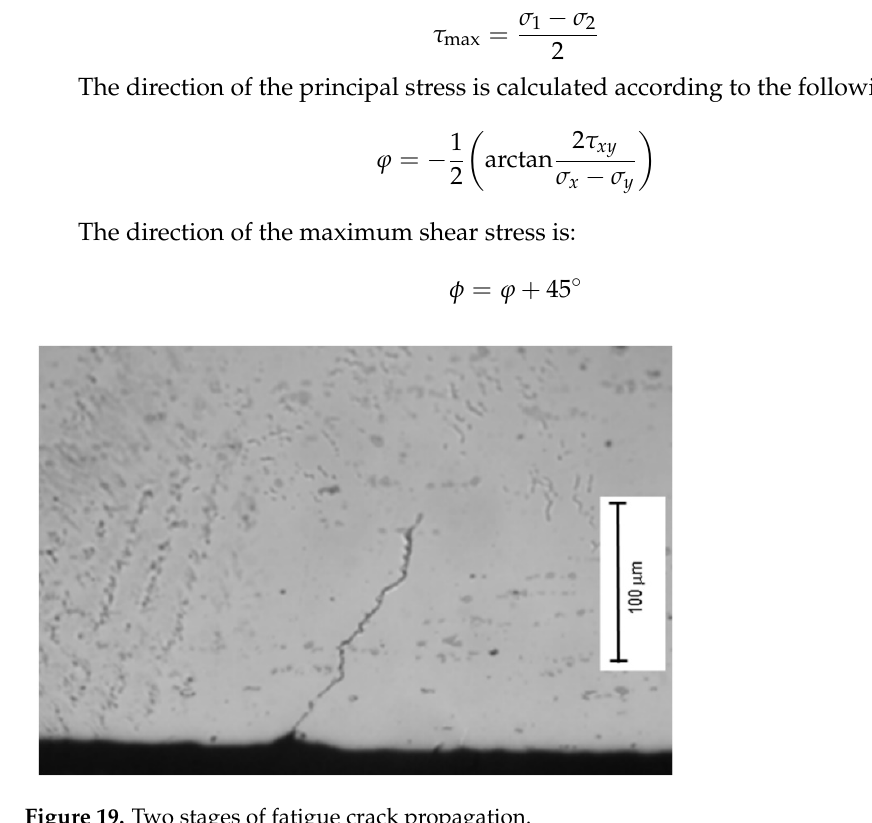
Figure 19. Two stages of fatigue crack propagation.